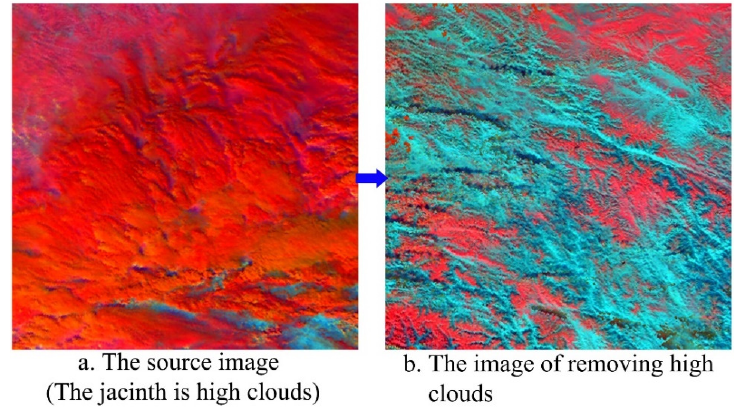
Figure 4. The medium-cloud-removed image ( a ) and its source image ( b ).